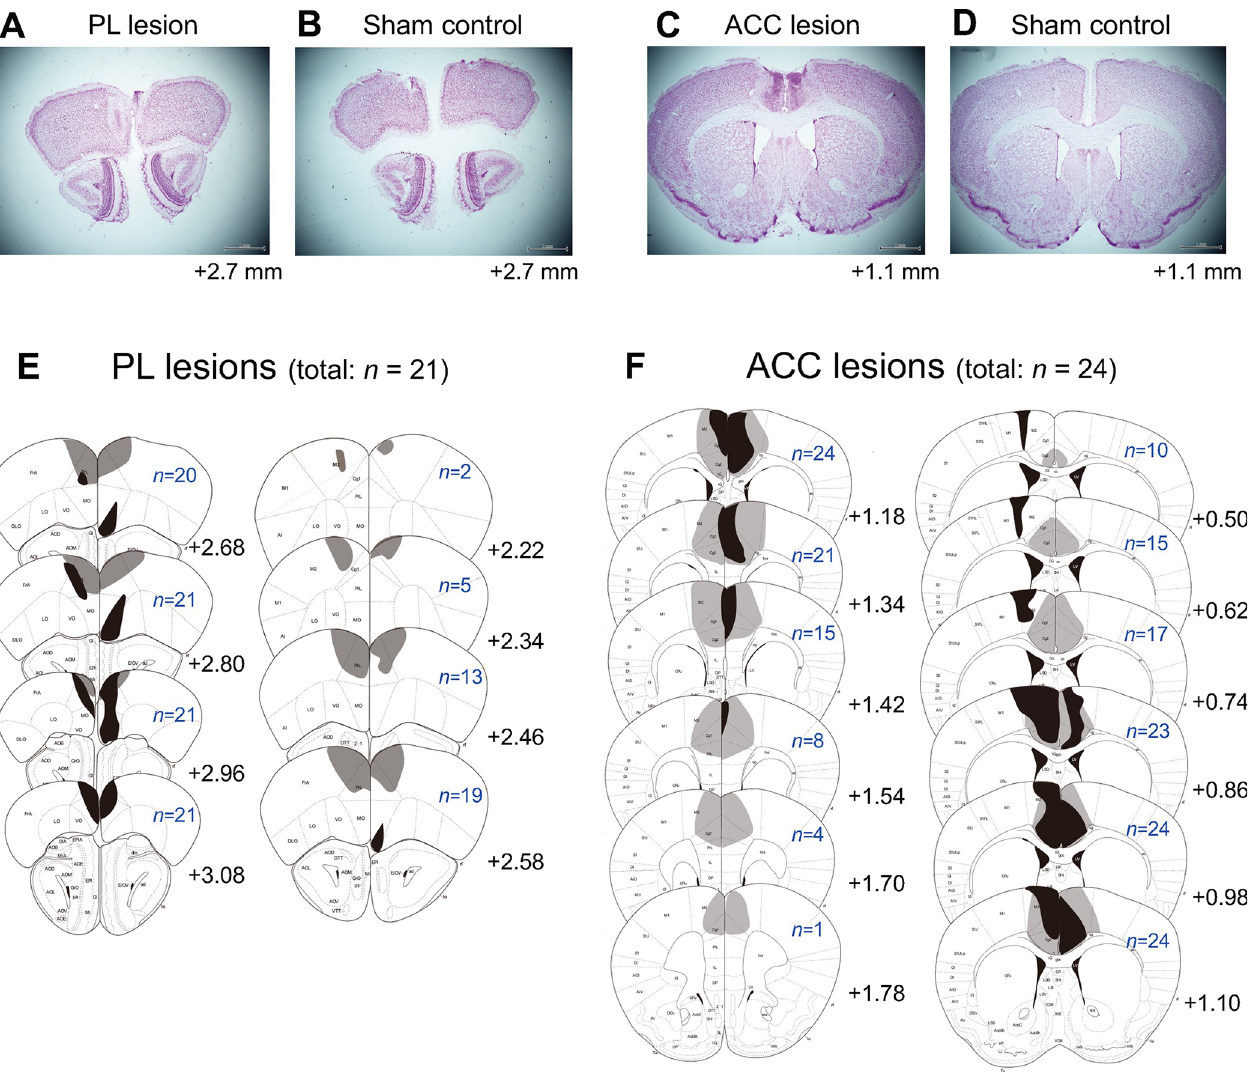
Fig 6. Representative brain sections from the prelimbic cortex (PL)-lesioned (A) and sham control mice (B), and the maximum (light gray areas) and minimum (dark gray shaded areas) extent of cell loss in PL-lesioned mice (E). All PL-lesioned mice exhibited injury in the PL and frontal association cortex. Representative brain sections from the anterior cingulate cortex (ACC)-lesioned (C) and sham control mice (D), and the maximum (light gray areas) and minimum (dark gray shaded areas) extent of cell loss in ACC-lesioned mice (F). All ACC-lesioned mice exhibited injury in the ventral and dorsal ACC and secondary motor cortex. The black numbers indicate the anteroposterior distance (mm) of the sections relative to the bregma. The blue numbers indicate the number of animals for which the brain sections were lesioned. All scales indicate 1 mm.